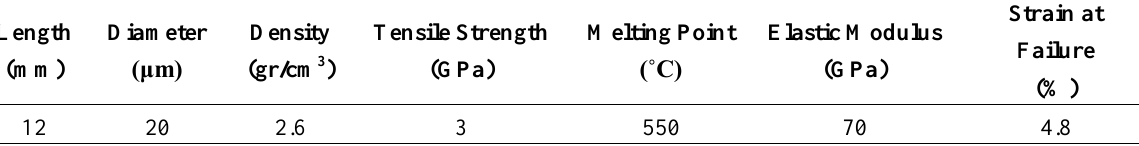
Table 4. The properties of the fibers used in this research